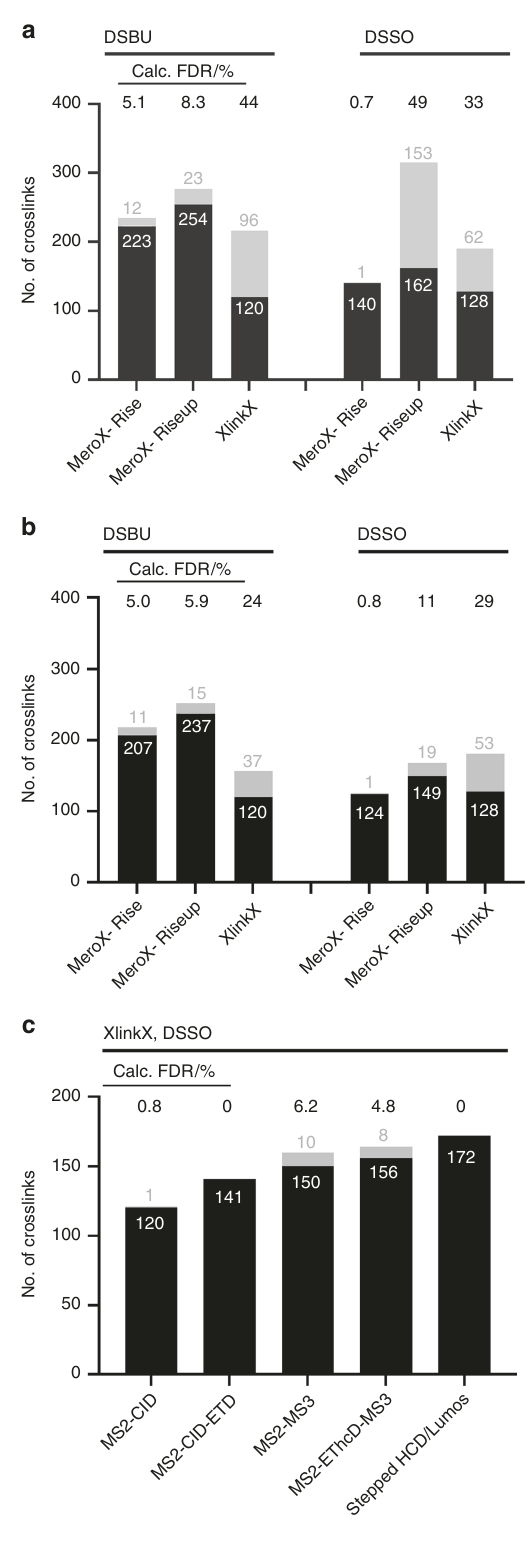
Biotin removal . After digestion, the biotin-linker region was removed with streptavidin beads. Twenty- fi ve microliters of slurry was washed three times with 25 µl ABC buffer. In all, 5 µl peptides + 20 µl ABC buffer was loaded onto the beads and incubated for 30 min. The eluate was removed and the beads were washed with 25 µl 0.1% FA and subsequently 25 µl 30% MeOH. The eluates were combined and reduced to 5 µl in a centrifugal concentrator to remove the